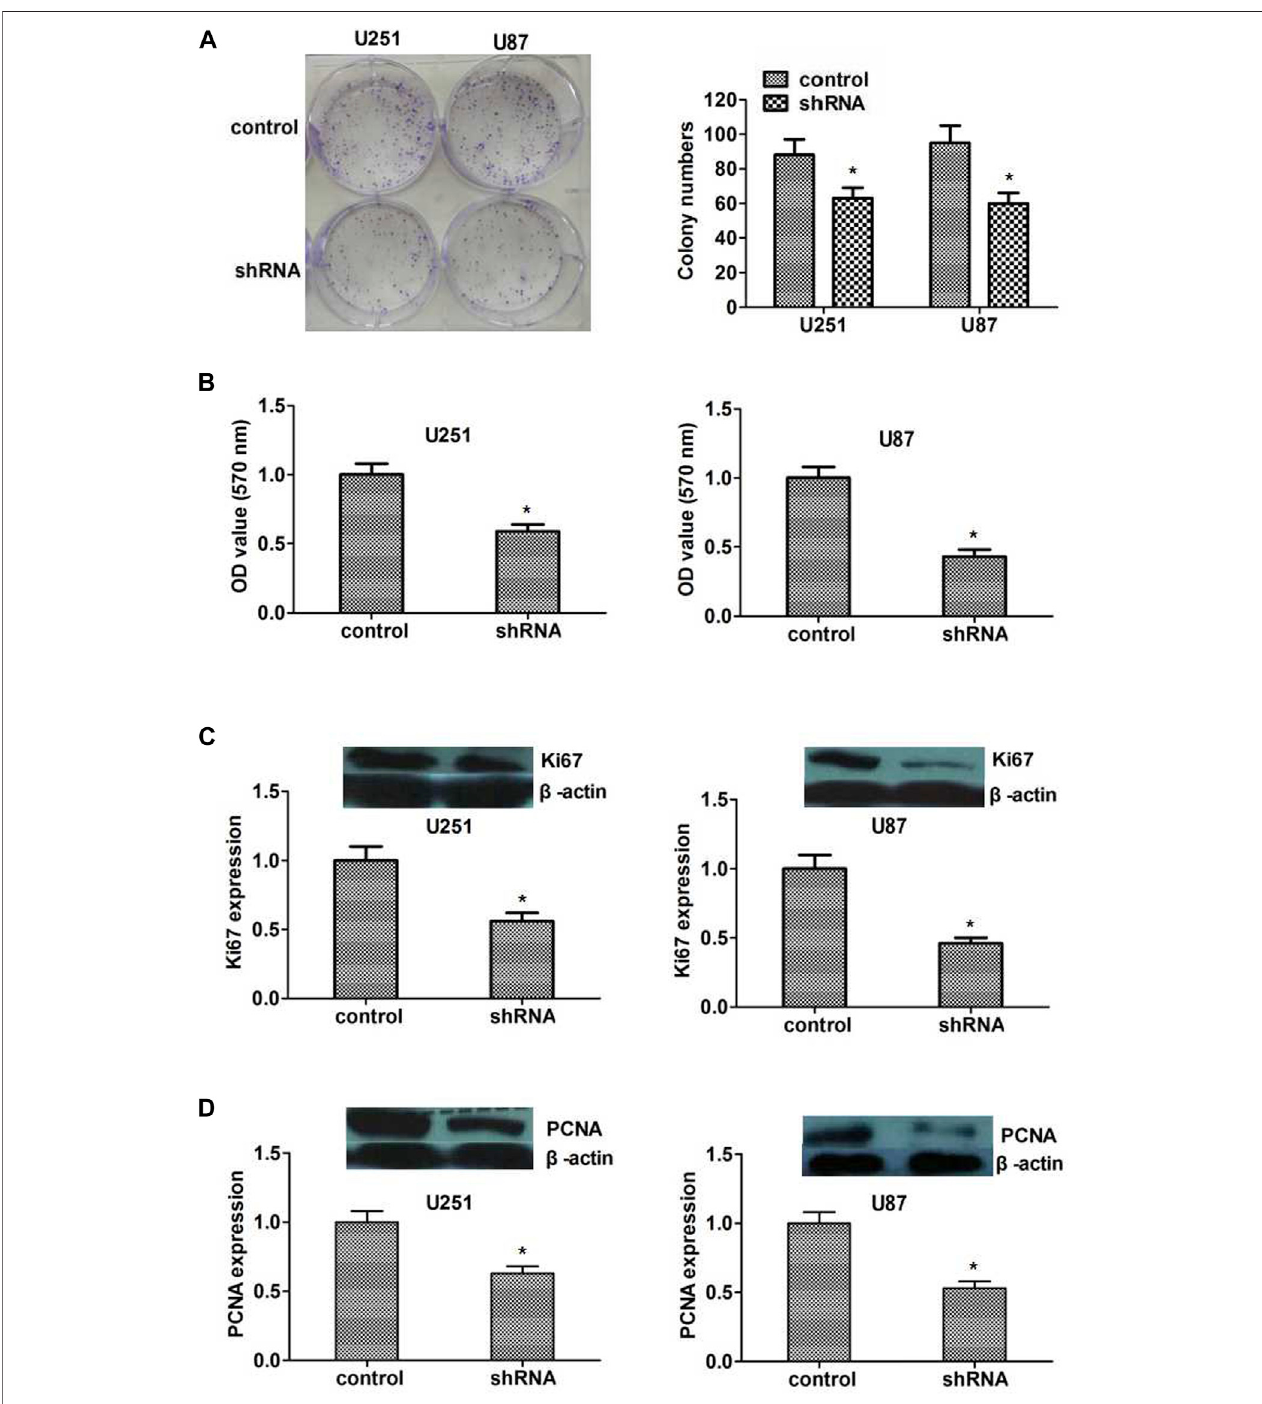
FIGURE 5 | KIF18A promotes GBM cell proliferation in vitro . (A) The differences in the proliferative capacity of GBM cells after treatment. (B) MTT analysis shows that plasma transfer of KIF18A shRNA has an inhibitory effect on cell proliferation. (C, D) Immunity Blog showed that inhibition of KIF18A greatly reduced the expression of Ki67 and PCNA. Results are expressed as overall standard deviation, * p <